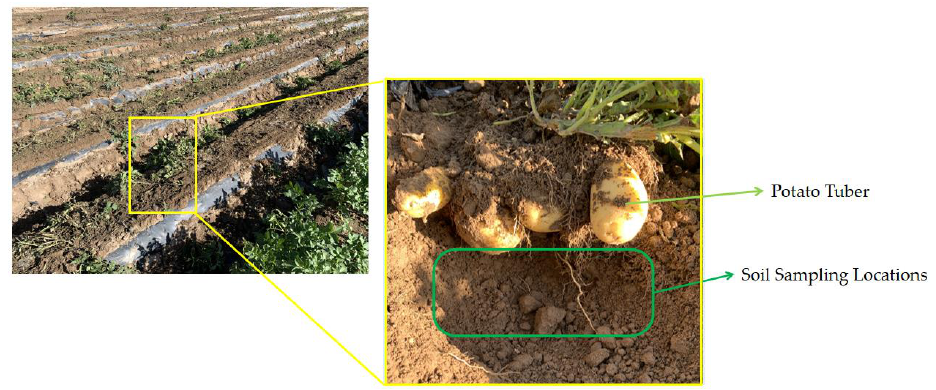
Figure 1. Sampling location for test soil.